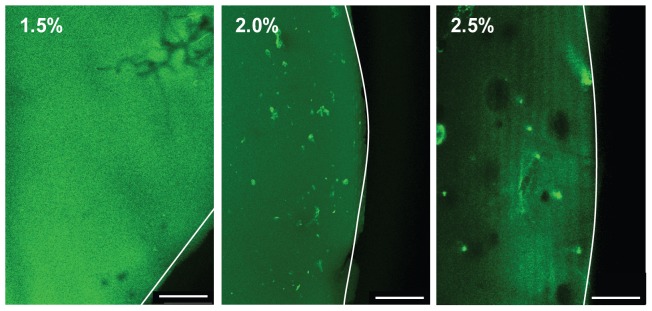
Characterization of LNCaP cell growth cultured within biomimetic hydrogels in normal growth media, RPMI and 10% FBS.(A) Growth curves of LNCaP cells over 7 days for 2D cultures (left) and 28 days for 3D cultures (right) in normal growth media measured by total DNA content (mean ± SE). In 2D cultures cells proliferate much faster reaching confluency within 7 days (top panel, left). The growth profile of cells is dependent on the mechanical properties of the bioengineered PEG matrices, where growth rate is highest in 1.5% followed by cells grown in 2% hydrogels (top panel, right). No cell proliferation is detected in the stiffer hydrogels (2.5%). Live-dead examination was performed using fluorescein diacetate-propidium iodide staining on day 24 of LNCaP cells grown in different PEG content (lower panel). The live-dead staining reveals that most cells are viable (green) in both 1.5 and 2.0% hydrogels but not viable (red) in 2.5% hydrogels. Images were taken with CLSM (10×, 0.4 NA). Bright field images also confirm that cells in 2.5% hydrogels did not form colonies as observed in 1.5% and 2.0% hydrogels at day 28. (B) (top panel) A representative CLSM 3D projections of LNCaP colonies labeled with Phalloidin (actin, red)/DAPI (nuclei, blue) from day 7 to day 28 (20×, 1.0 NA). Colonies are more rounded at day 7 and day 14 but become irregular aggregates from day 21 onwards. Box plots of colony size and shape factor analyzed from six CLSM images (bottom panel) show significant increase in spheroid size and decrease in shape factor (p<0.001) at day 28 relative to day 7 cultures are detected. (C) A representative histology section of day 28 cultures reveal the formation of invasive ‘fingers’ (arrow) penetrating the surrounding hydrogel (left). The H&E stain (middle) shows a hollow core. Immunohistochemistry stain of Caspase 8 (right) confirms apoptotic cells within the core (brown). (D) Scatter plots of colony size, cell number and core size if any analyzed from 10 µm thick histology sections. This shows that each colony size increases linearly with the cell number. Core size also increases linearly with the colony size. At least three independent experiments were conducted for each analysis. Scale bars: (A, left, B) 250 µm, (A, right) 100 µm and (C) 50 µm.